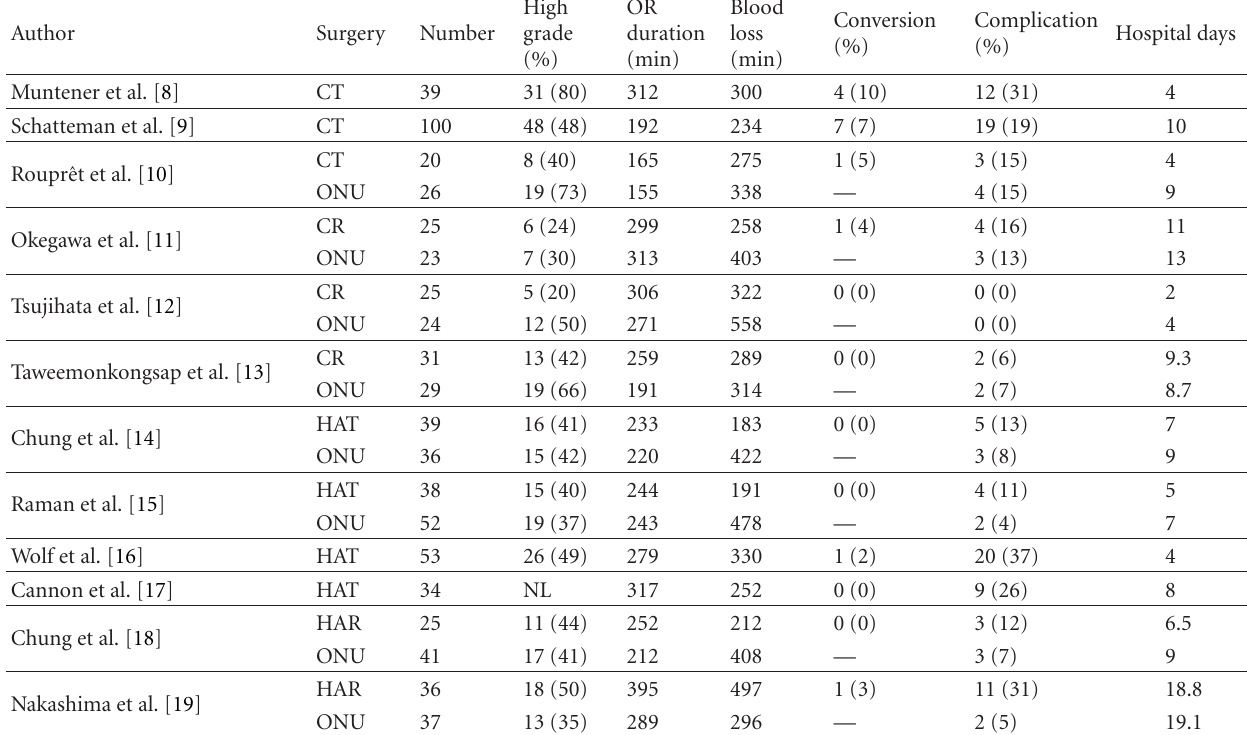
Table 1: Perioperative characteristics of LPN versus ONU cases. CR, conventional retroperitoneal; CT, conventional transperitoneal; HAT, hand-assisted transperitoneal; NL, not listed; ONU, open